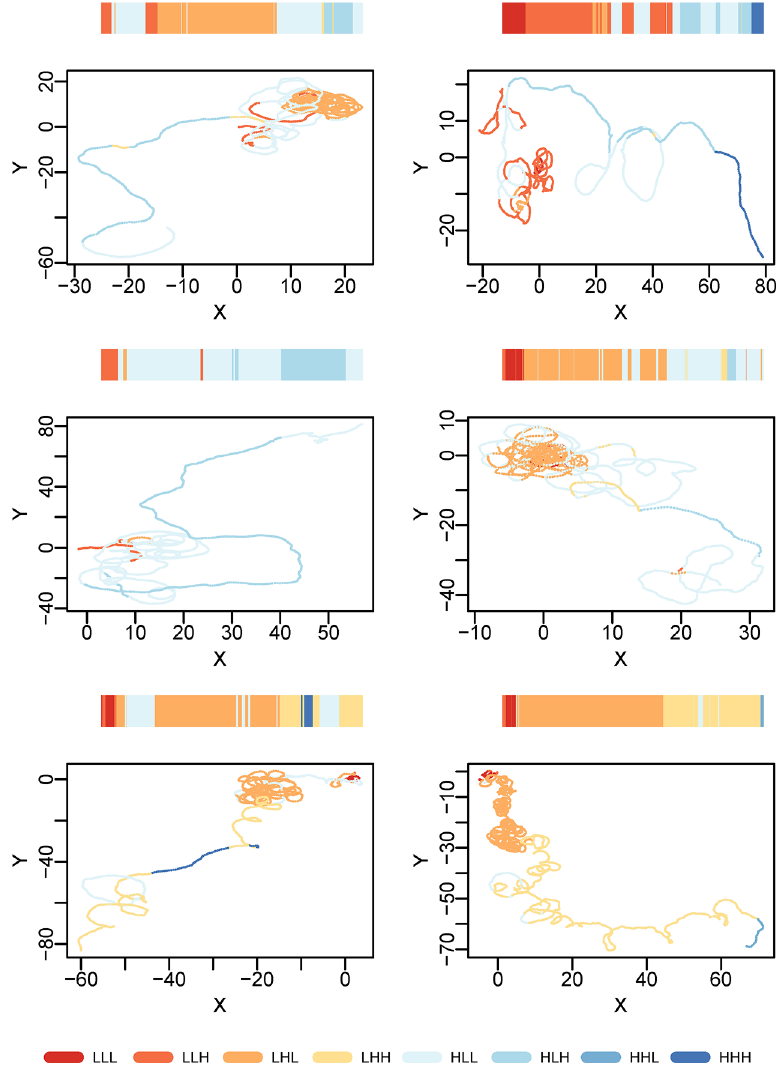
Fig 10. C.elegans ( Caenorhabditis elegans ) search trajectory. Trivariate clustering of 6 solitary nematode trajectories crawling in an agar plate (with a sampling frequency of 32 Hz and 90 minutes of trajectory time). The clustering is performed at population level (all data points at the same time) and is afterwards visualized on each individual trajectory. The algorithm captures different behaviours in terms of intensity of local search, looping behaviour and